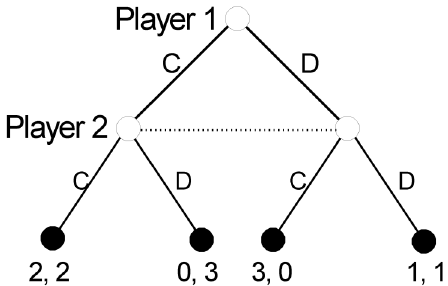
Figure 4. Prisoner’s